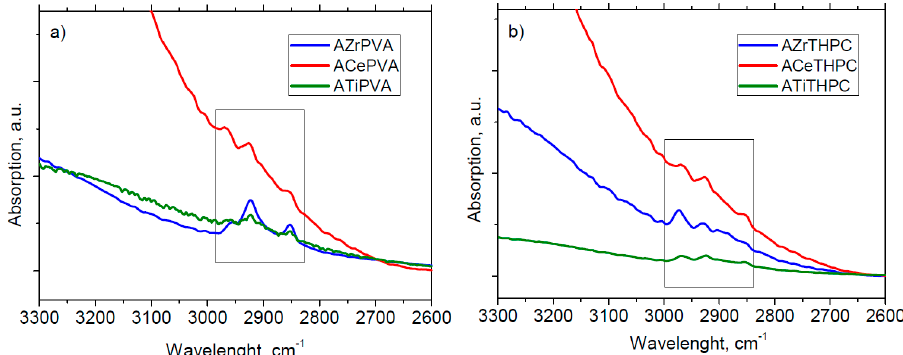
Figure 2. FT ‐ IR spectra for catalysts synthesized by sol immobilization method with PVA (section a ) and THPC (section b ).